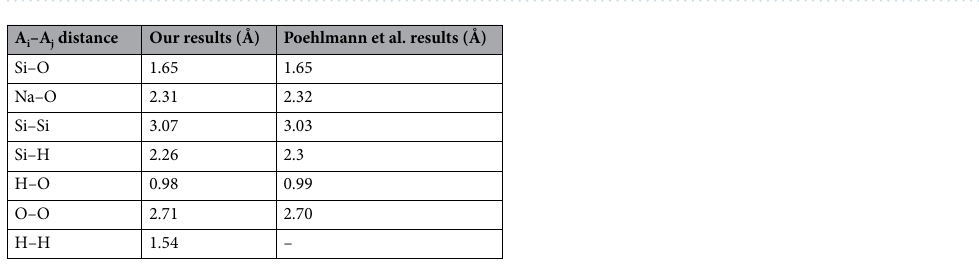
Figure 3. Select g ij (r) partial pair distribution functions and the corresponding running CNs (rCNs) for the simulated dry (solid red lines) and hydrous (dashed or solid blue lines) albite melts. The plots for the remaining g ij (r)‘s and running CNs are presented in Fig. S3. Note that the g Al-O (r) was calculated with oxygens originating from the albite structure and from the H 2 O dissolved in the melt under simulated high P–T conditions.